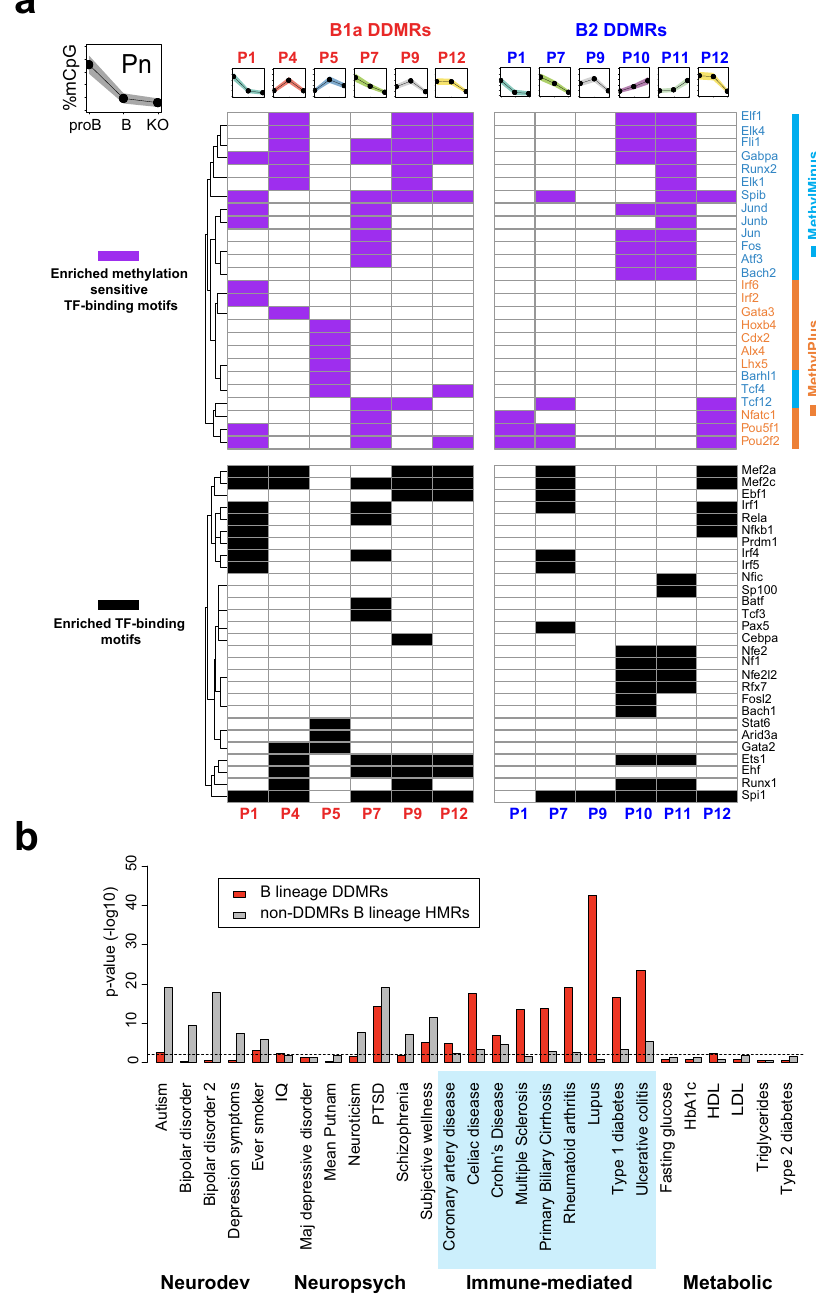
Fig. 8 DMEs are enriched for TF-binding motifs and SNPs associated with immune-mediated diseases. a Signi fi cantly enriched TF-binding motifs in B1a and B2 DDMRs with varying patterns of methylation. Enriched motifs were fi ltered by p < 0.01 (binomial test run with HOMER) and a difference in motif instances between test and background sets of intervals greater than 5%; the entire set of DDMRs was used as the background. Motifs that are insensitive to CpG methylation or lack a CpG are depicted in black. Methylation-sensitive transcription factor binding motifs are marked in magenta and colored based on whether the colored by TF binding is enhanced (orange) or inhibited (cyan) by CpG methylation. b Enrichment of SNPs linked to human disease in GWAS in B lineage DMRs (red) and all HMRs excluding the DMRs (gray) calculated using RiVIERA. Source data are provided as a Source Data fi